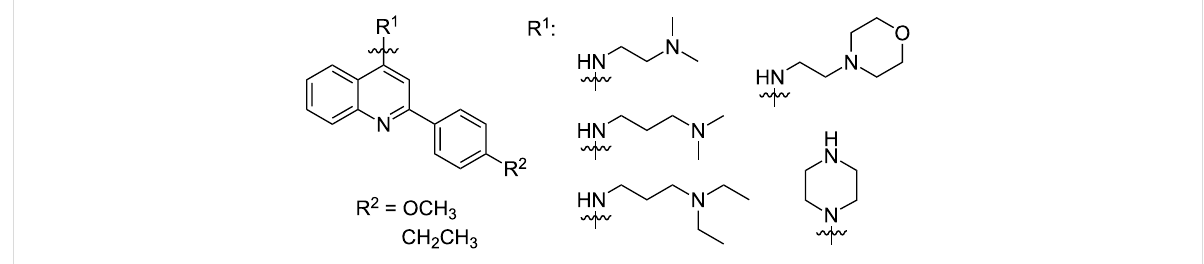
cytoplasmic RNAs in stress granules [39-41]. One approach to alleviate the pathology caused by mutant TDP-43 is to identify small molecules that inhibit the binding of TDP-43 to nucleotides. Cassel et al. [42] developed a high-throughput screening assay whereby TDP-43 nucleotide binding could be assessed. A screen of 7360 compounds yielded a series of small molecules that disrupt oligonucleotide binding to TDP-43 protein [42]. Later, this series of 4-aminoquinoline derivatives (Figure 8) was tested for its ability to regulate TDP-43